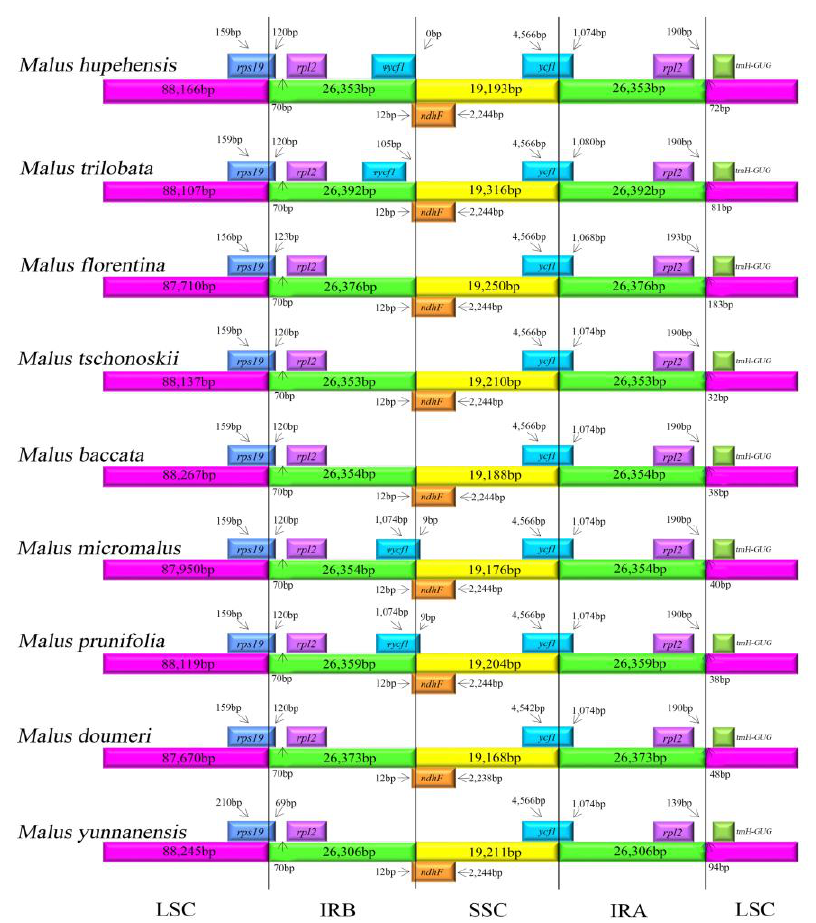
Figure 4. Comparison of the border positions of LSC, SSC, and IR regions among the nine Malus chloroplast genomes.